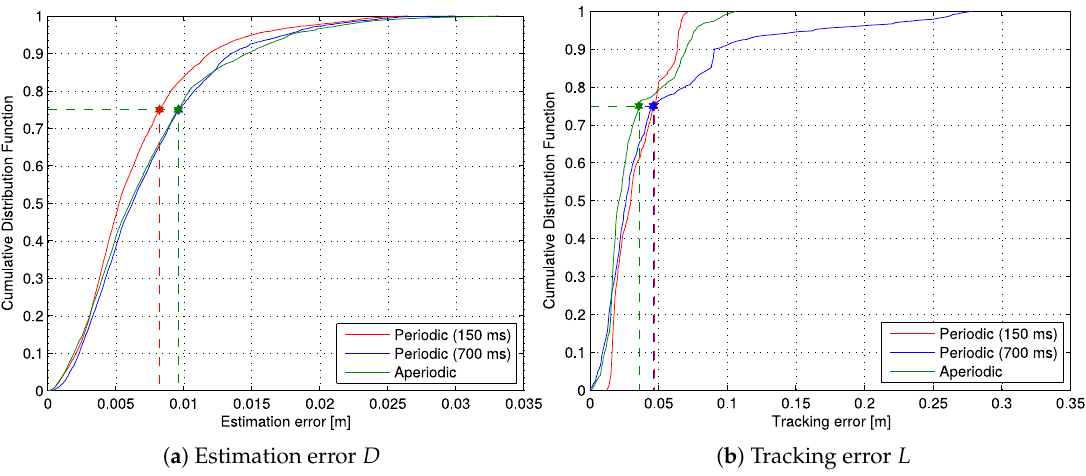
Figure 10. Estimation and tracking error cumulative distribution